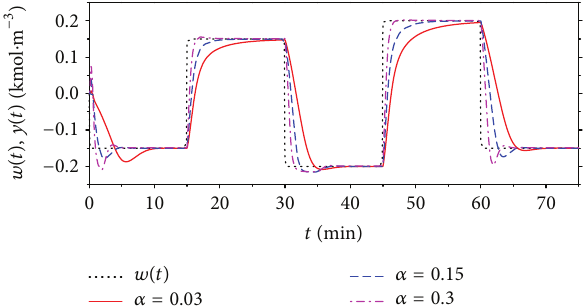
Figure 12: The course of the output variable 𝑦(𝑡) and the reference signal 𝑤(𝑡) forvariousvaluesofthetuningparameter 𝛼 fornonlinear adaptive